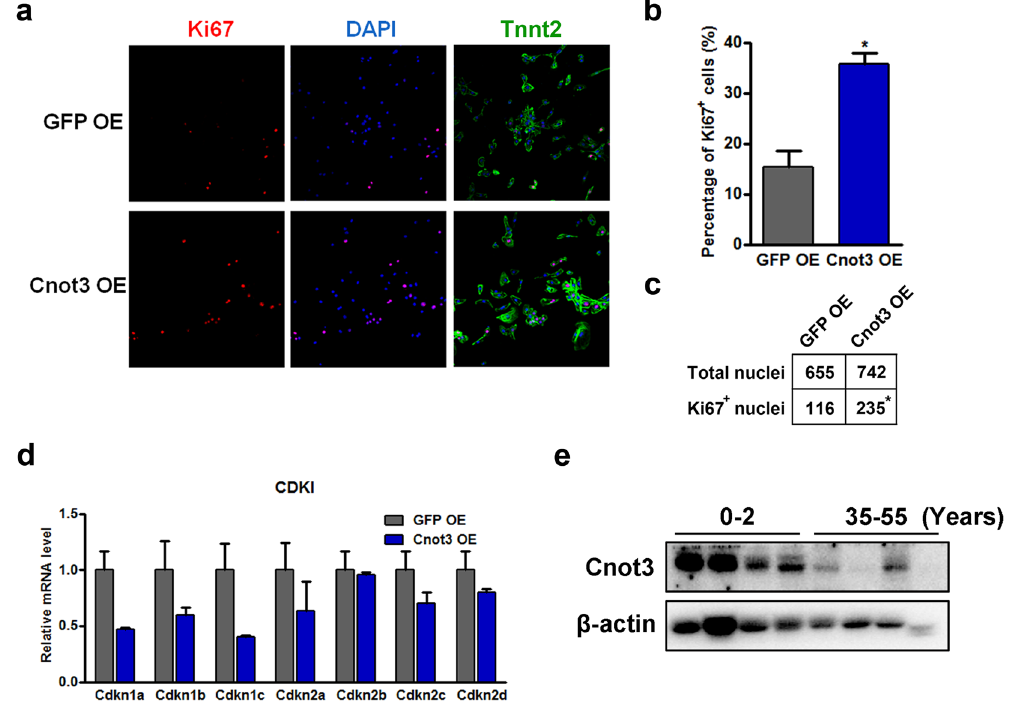
Figure 5. Cnot3 overexpression induces human cardiomyocyte proliferation. ( a ) Representative images of immunofluorescence staining against Ki67 and Troponin T2 (TnnT2) to show the impacts of Cnot3 overexpression on the proliferation of hESC-derived cardiomyocytes. ( b ) Percentage of Ki67 positive cells was counted, and plotted as mean ± SEM from ten images from three independent experiments, * p < 0.05. (c) Ki67 positive nuclei were counted from ten images from three independent experiments, and significance was calculated by chi-square test, * p < 0.05. ( d ) qPCR to show the expression of CDKI mRNA 96 hours after Cnot3 overexpression in hESC-derived cardiomyocytes. β -actin was used as endogenous control and values were plotted as mean ± SEM from three independent experiments. (e) Western blot to show the Cnot3 protein levels in human heart tissues from adult versus infant. β -actin was used as loading control. The blots were cropped since different antibodies were incubated at the same